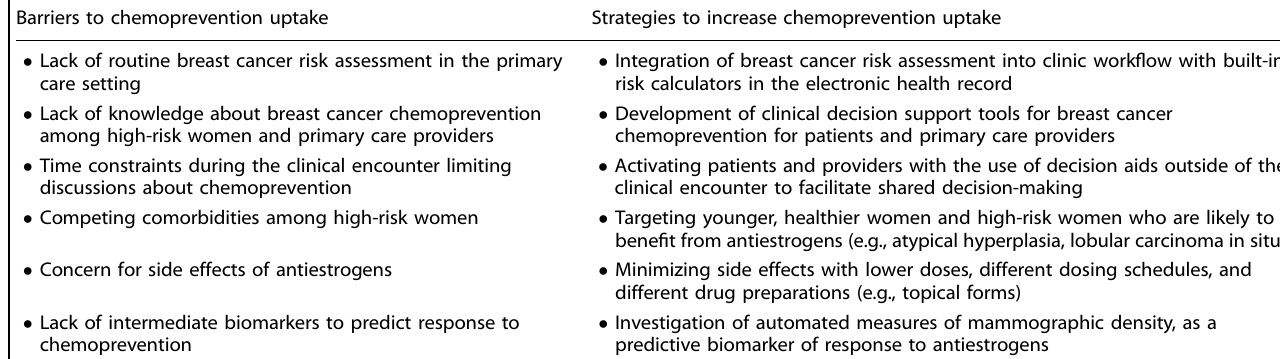
Table 3. Summary of barriers to chemoprevention and strategies to increase chemoprevention uptake among high-risk women Barriers to chemoprevention